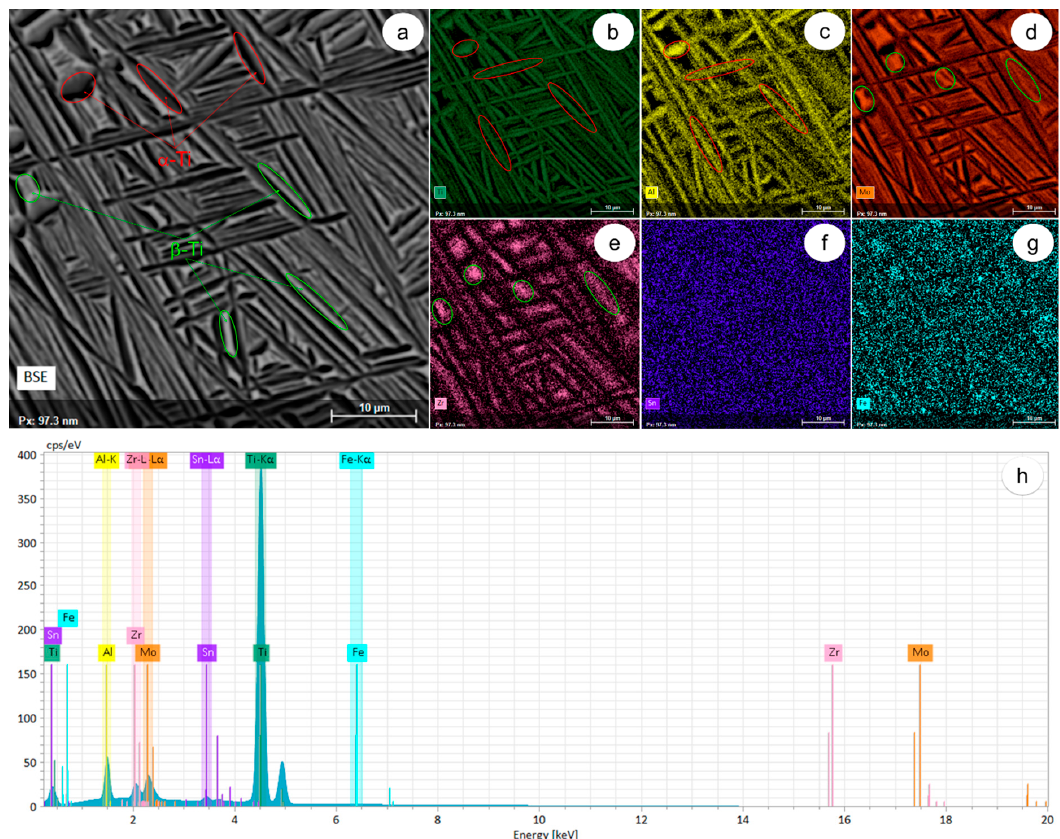
Figure 4. Distribution maps of main alloying elements in as-received (AR) Ti-6246 alloy: ( a ) SEM-BSE microstructural image; ( b ) SEM-EDS distribution map of Ti; ( c ) Al; ( d ) Mo; ( e ) Zr; ( f ) Sn; ( g ) Fe; ( h ) global EDS spectra. Table 1. Chemical composition of as-received (AR) Ti-6246 alloy. Element wt.% at . % Abs. Error (%) Rel. Error (%) Titanium 81.54 82.55 2.44 2.76